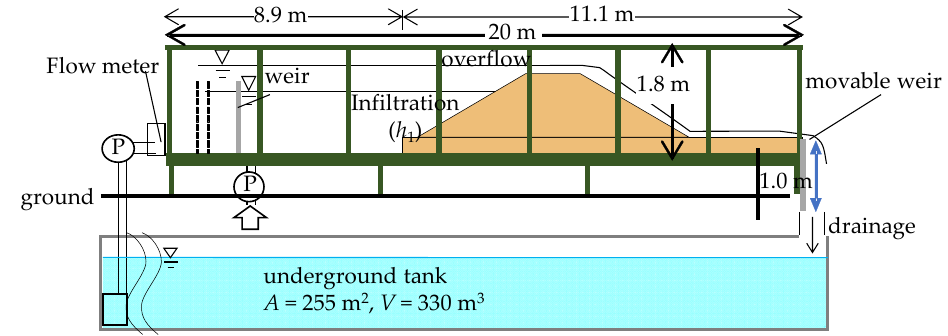
Figure 3. Outline of large channel used in the laboratory tests.